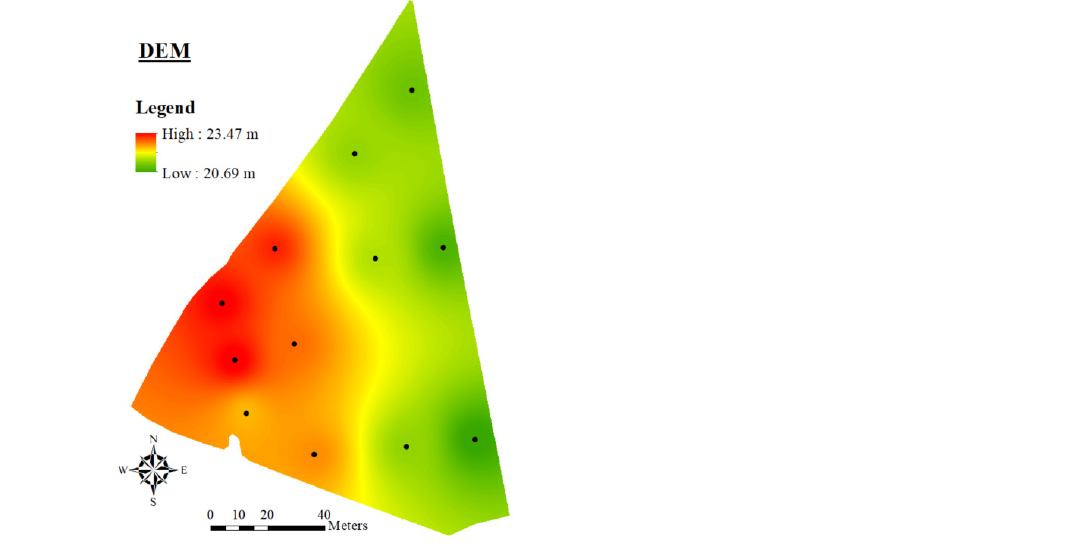
Figure 6. Digital elevation model (DEM) of the commercial field with the locations of the elevations marked with black dots.